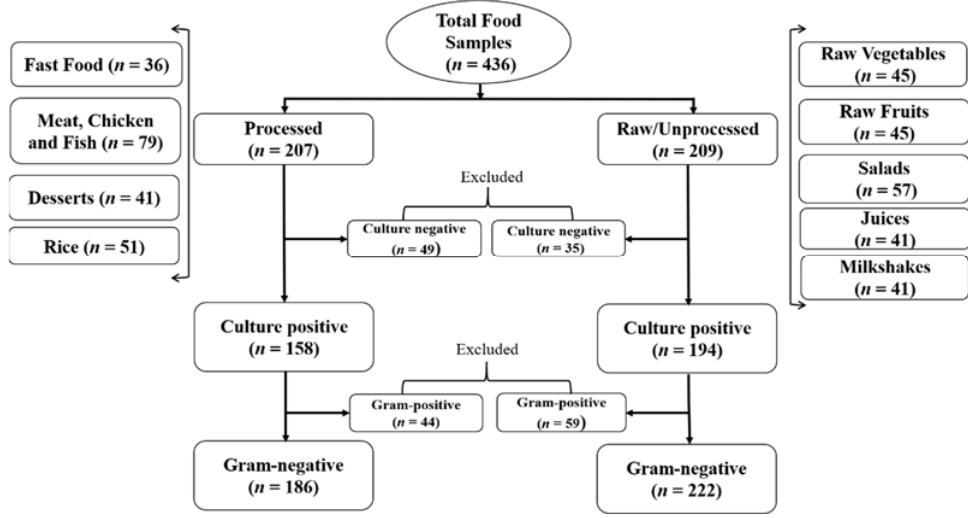
Figure 1. Types of food samples collected and processed in this study ( n = 436).